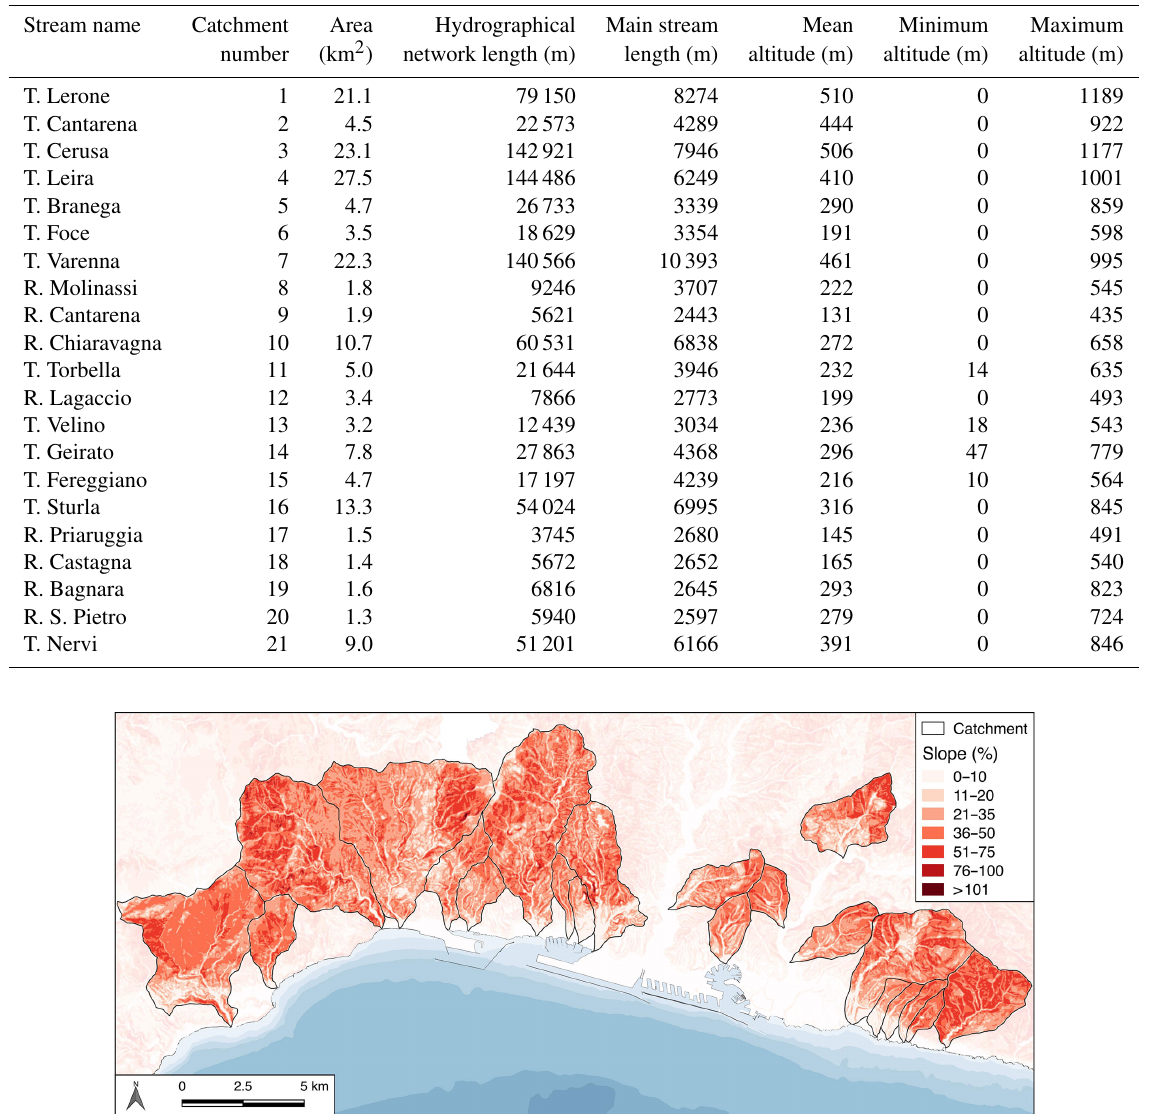
Table 1. The main morphometric features of the studied catchments.